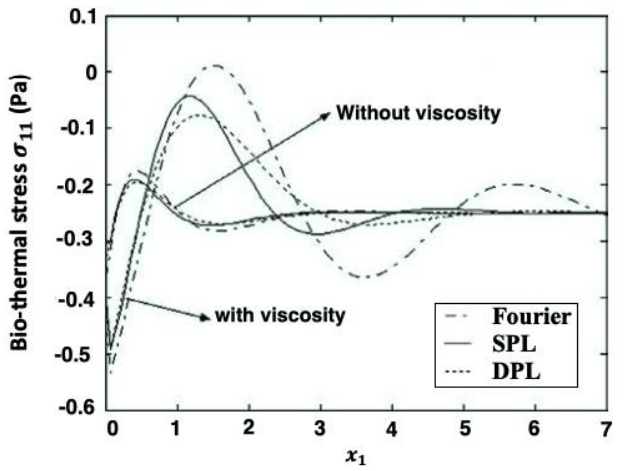
Figure 4. Biothermal stress 𝝈 𝟏𝟏 wave fluctuations along 𝒙 𝟏 – axis for various bioheat models.